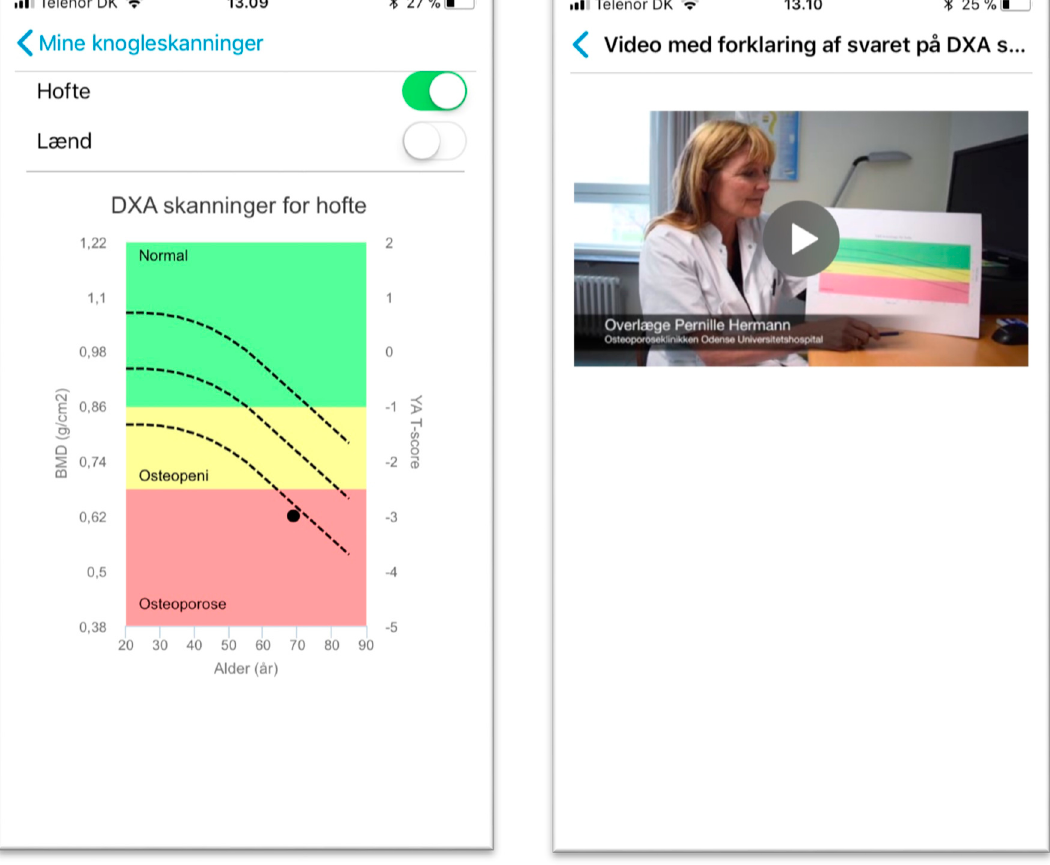
Figure 7. Screenshots from the menu item “My bonescans” (to the left) and the video with the chief physician explaining how to interpret the result of the DXA scan (to the right).